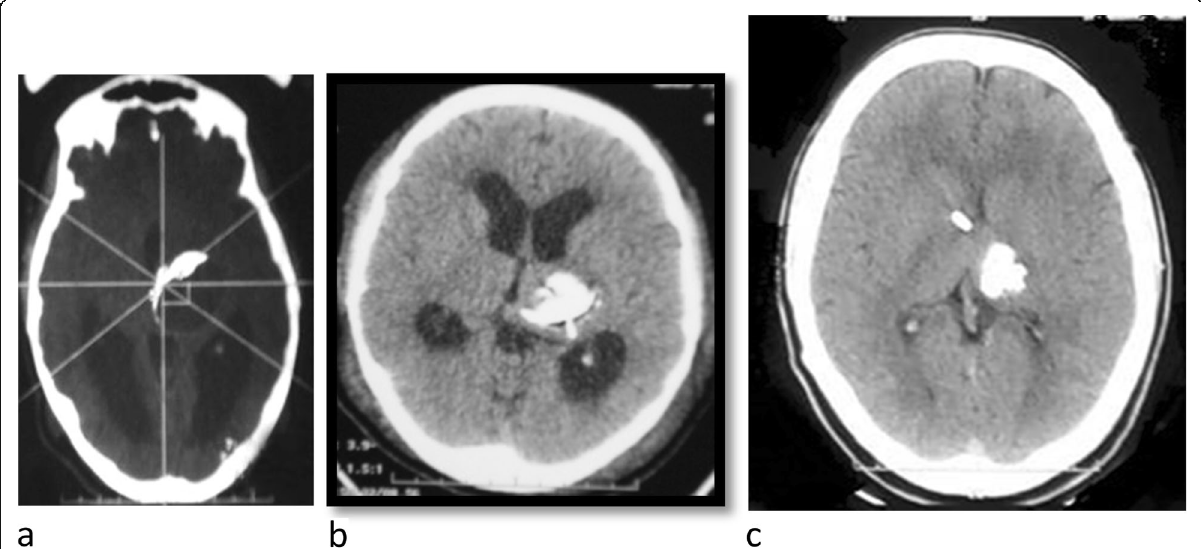
Fig. 6 a On the left stereotactic CT for aspiration and biopsy from left thalamic pilocytic astrocytoma, b : on the right CT brain post stereotactic